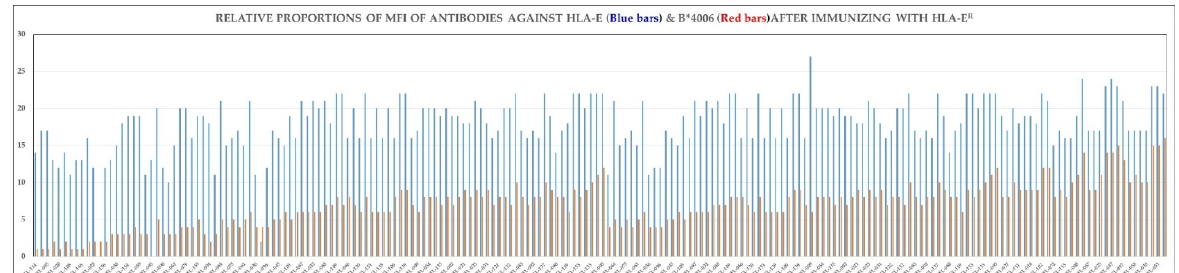
Figure 6. MFI of mAbs reacting to HLA-E R and B*4006, a major HLA-Ia antigen recognized by al- most all mAbs.